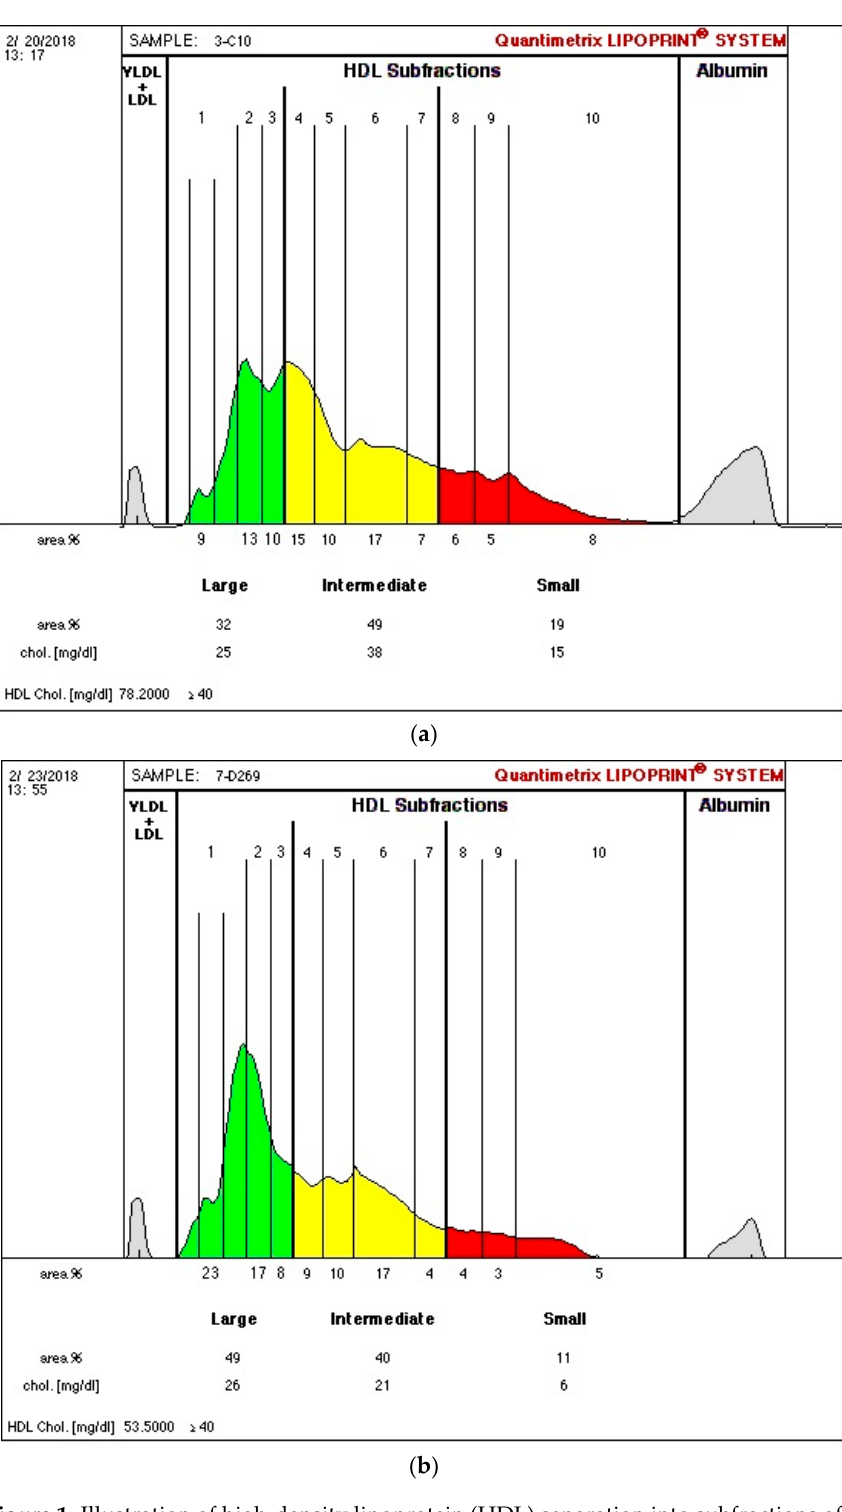
Figure 1. Illustration of high-density lipoprotein (HDL) separation into subfractions of one studied control ( a ) and one end-stage renal disease patient on dialysis ( b ) using the Lipoprint® kit from Quantimetrix Corp. (Redondo Beach, CA, USA). (HDL is separated into 10 subfractions that are classified as large HDL (1–3 subfractions—green color), intermediate HDL (4–7 subfractions—yellow color), and small HDL (8–10 subfractions—red color)).